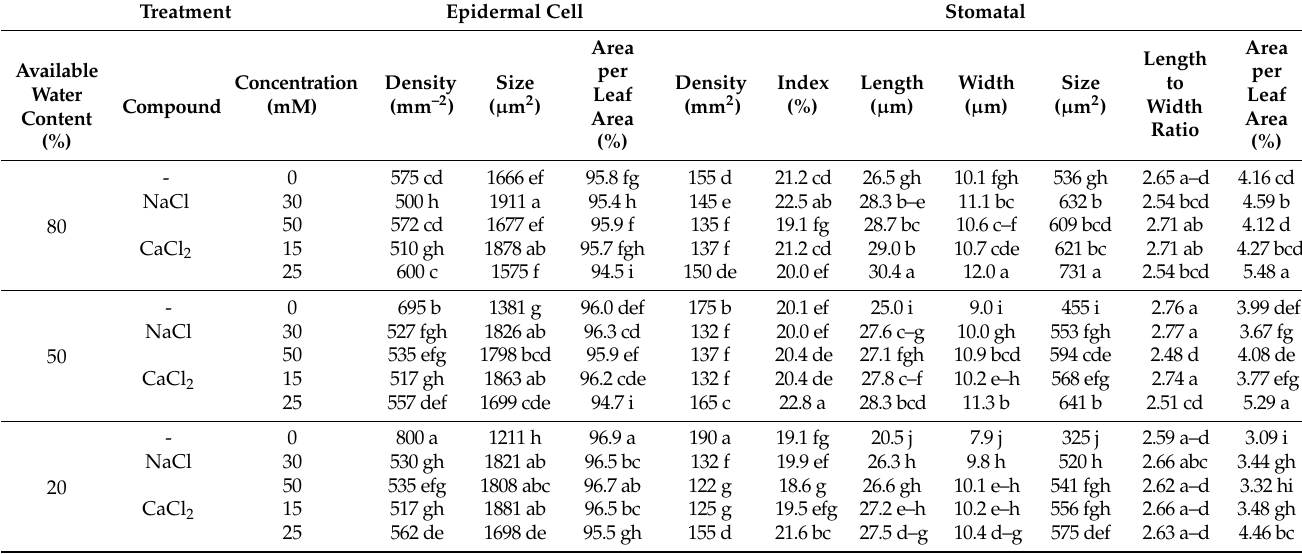
Table 4. Epidermal cell and stomatal anatomical features of periwinkle cv. ‘Pacifica XP Really Red’ plants initially receiving NaCl (0, 30 and 50 mM) or CaCl 2 (15 and 25 mM) via irrigation (five applications at 3 d intervals), and subsequently exposed to different watering levels (80, 50 and 20% available water content) during cultivation. At first application, plants were at the four-leaf stage. Means followed by different letters indicate significant differences ( p = 0.05; comparison in columns). Values are the mean of four replications.